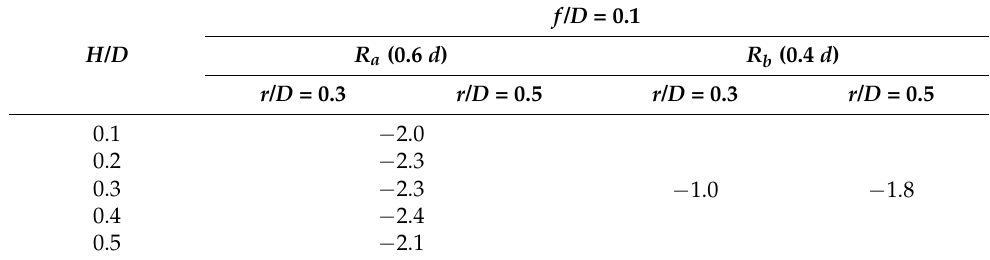
Figure 21. Proposed peak net pressure coefficients for the central open dome: ( a ) C pn,min and ( b ) C pn,max . Table 11. Proposed negative peak net pressure coefficients.